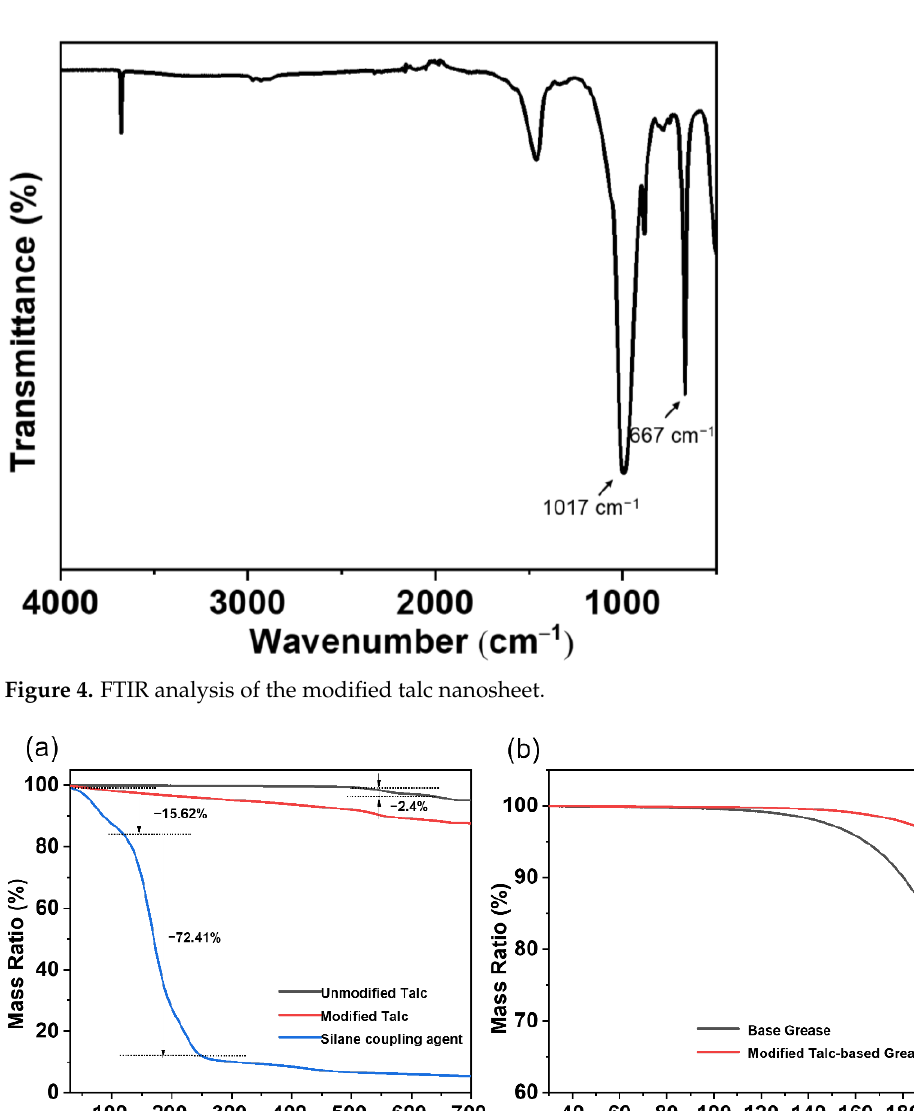
Figure 5. The thermal stability of the talc nanosheets ( a ) and grease ( b ).